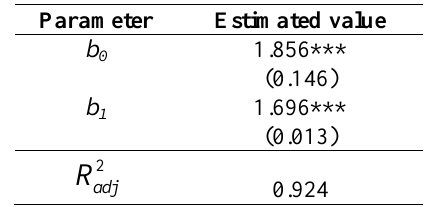
Table 3 : Estimation results for Equation